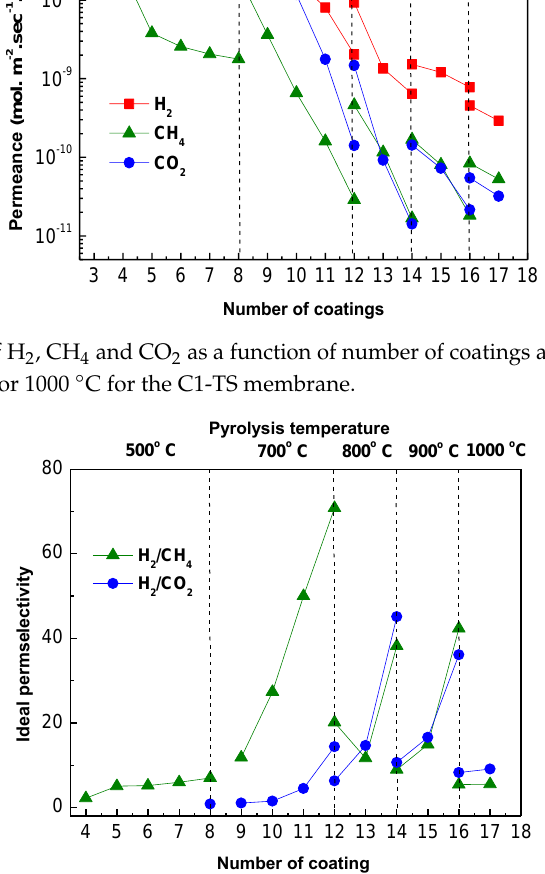
Figure 10. Corresponding H 2 / CO 2 and H 2 / CH 4 ideal selectivities for the results of Figure 9, C1-TS membrane.